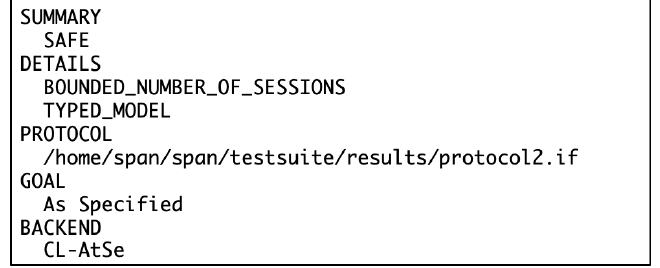
Figure 15. Output of CL-AtSe backend for low security risk.